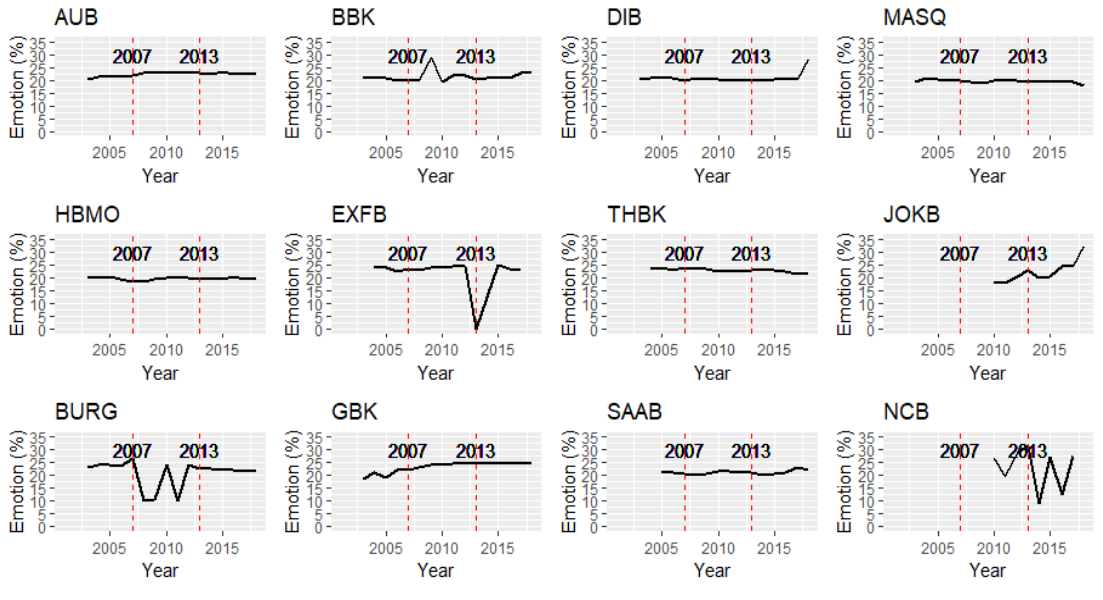
Figure 1. The trend of all emotional words in banks’ annual reports (from 2002 to